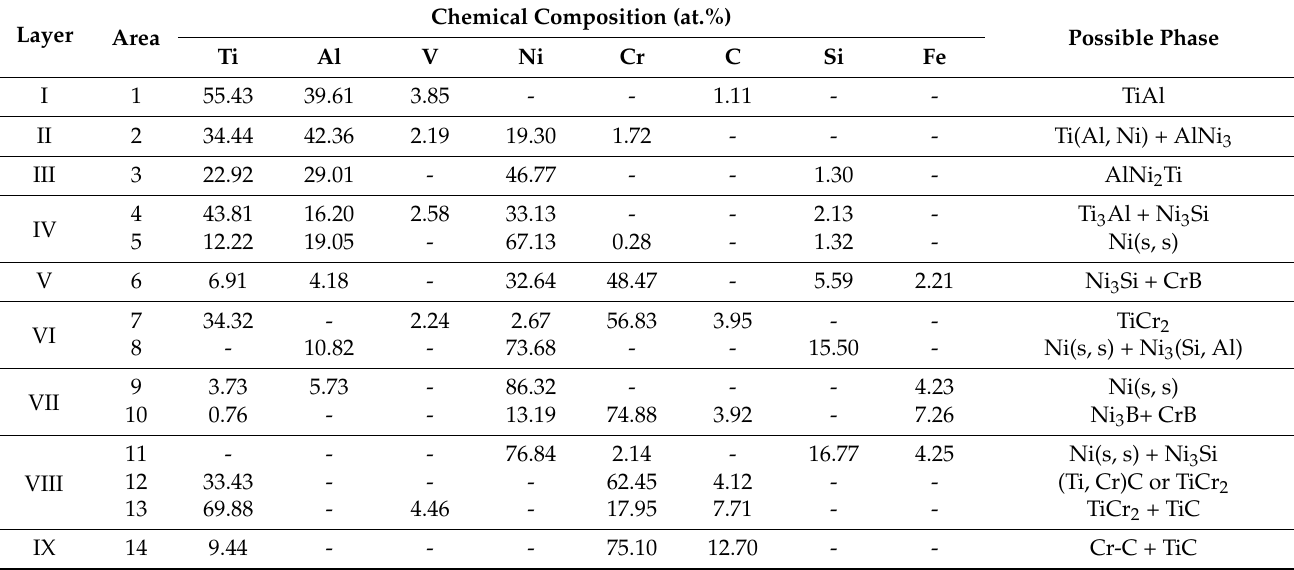
Figure 3. BSE Morphologies of C/C-BNi2-TiAl brazed joint under 1060 °C /20 min parameter: ( a ) Overall morphology of the joint, ( b ) Cross section morphology of the joint. Table 2. EDS analyses of typical areas in Figure 3b.